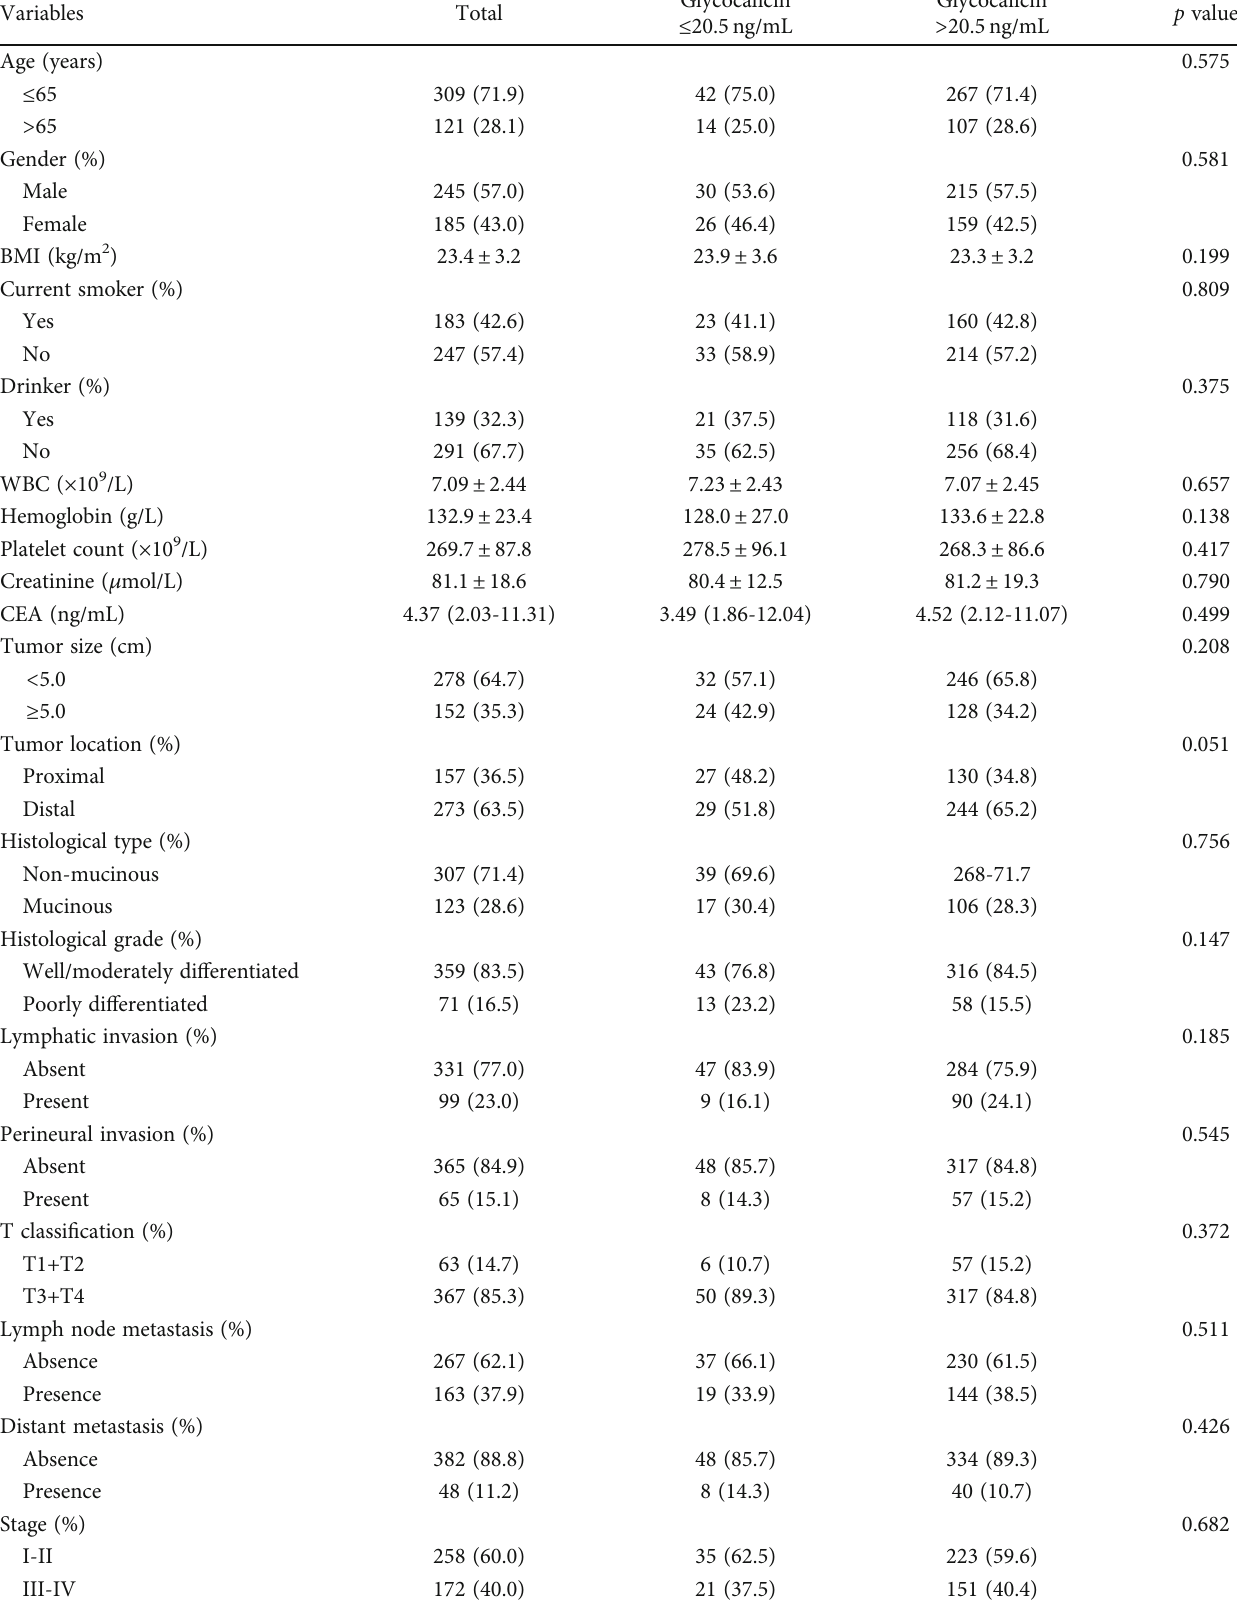
Table 1: Baseline characteristics of CRC patients according to glycocalicin